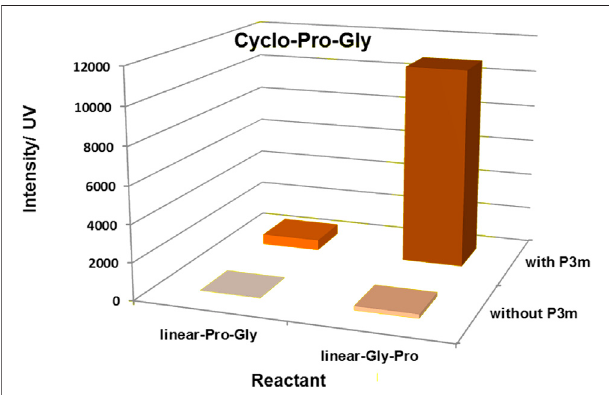
FIGURE 4 | Effect of P 3 m and the sequence of linear dipeptides on the formation of cyclo-Pro-Gly. All reactions were controlled under standard conditions.